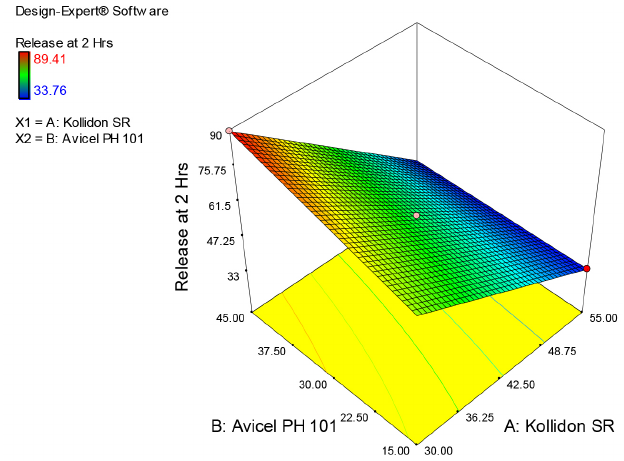
FIGURE 8c - Response surface model (RSM) showing effect of independent variables Kollidon SR and Avicel pH 101 on Drug release in 8